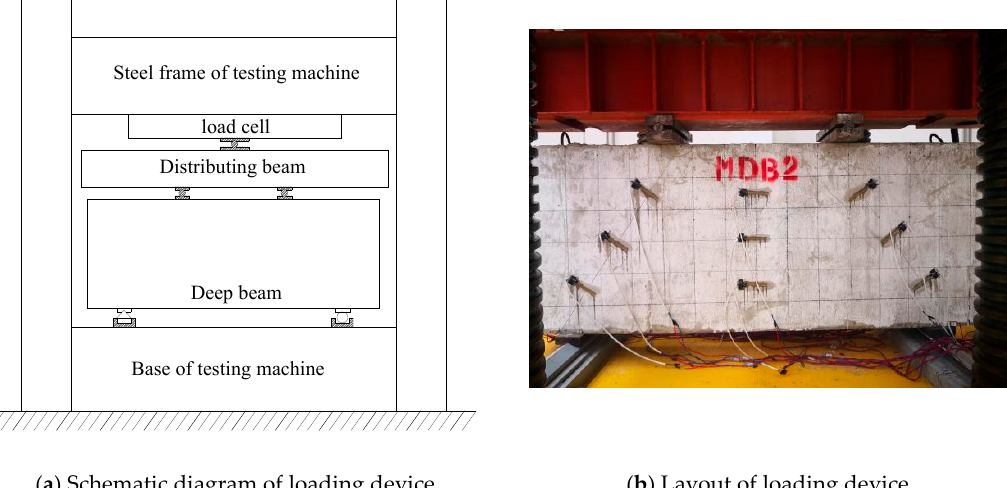
Figure 2. Test loading device.